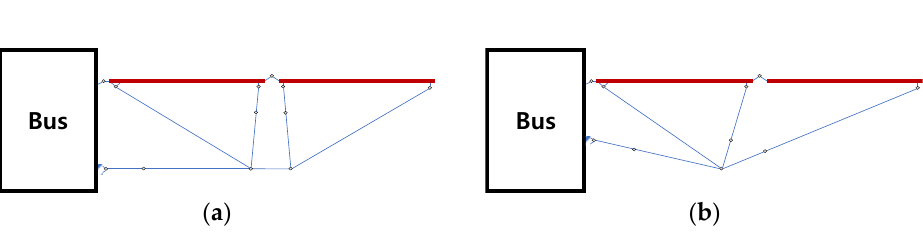
Figure 1. Configuration of 2-D truss-link mechanism: ( a ) Type 1 (RADARSAT-1) ( b ) Type 2 (RADARSAT-2). Table 1. Evaluation of total DOF.